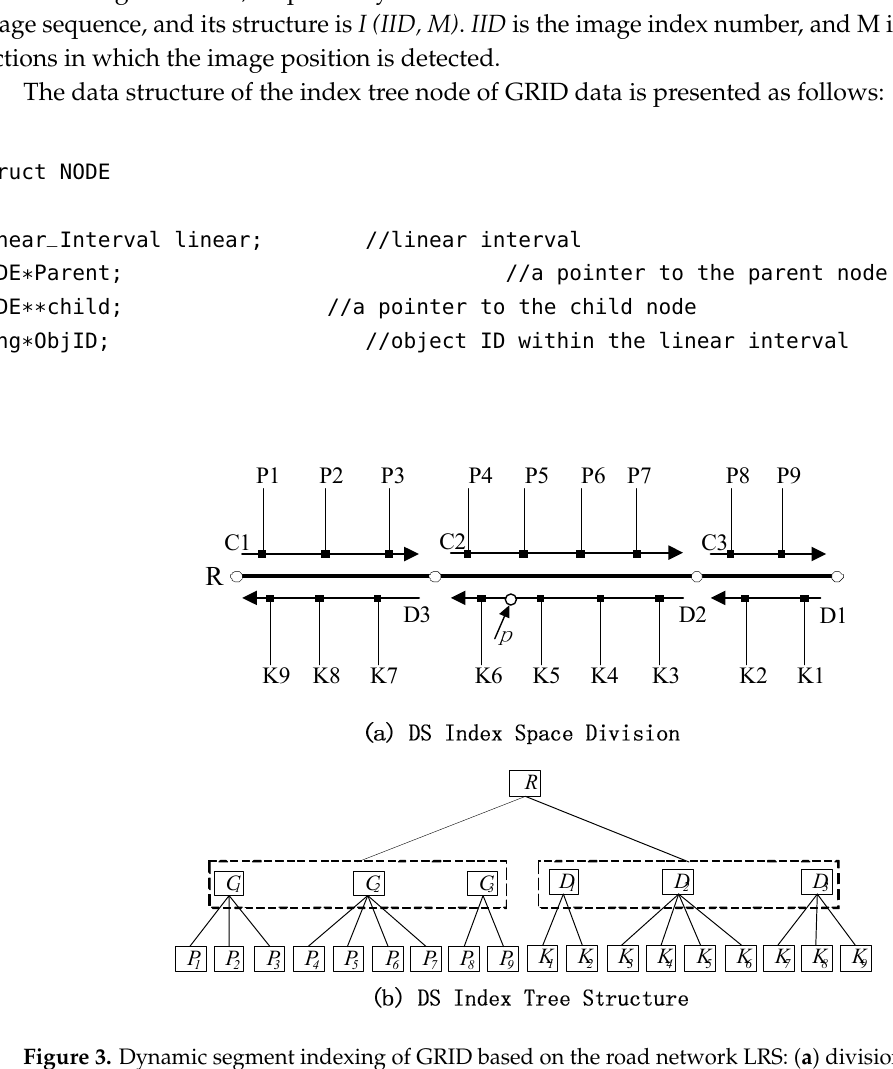
Figure 3. Dynamic segment indexing of GRID based on the road network LRS: ( a ) division of DS index space; ( b ) structure of the DS index tree.